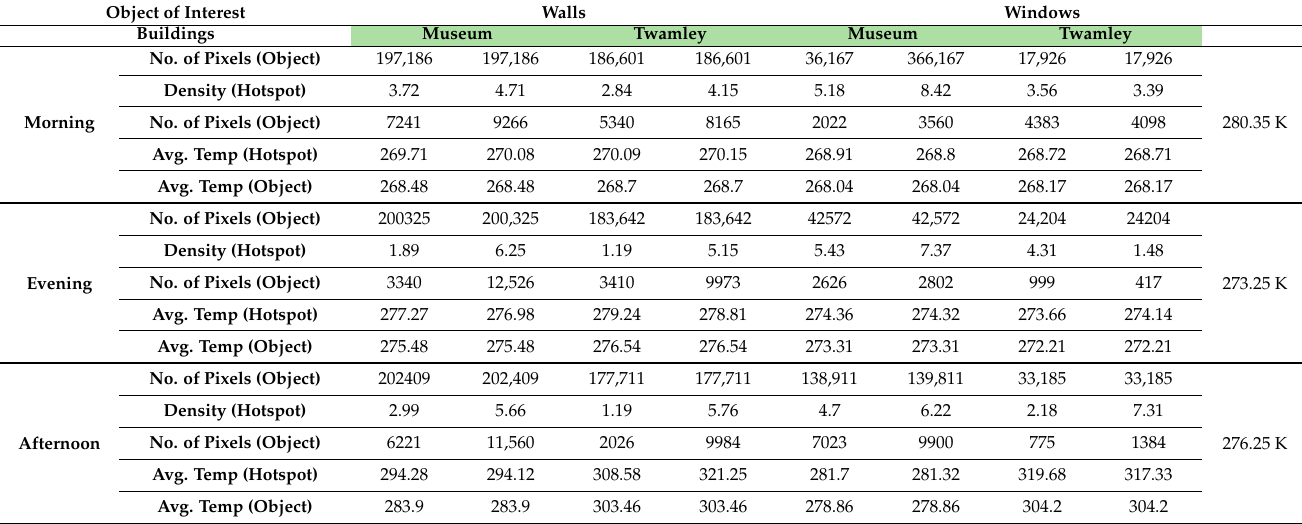
Table 8. Performance of K-means and Threshold-Based Clustering.